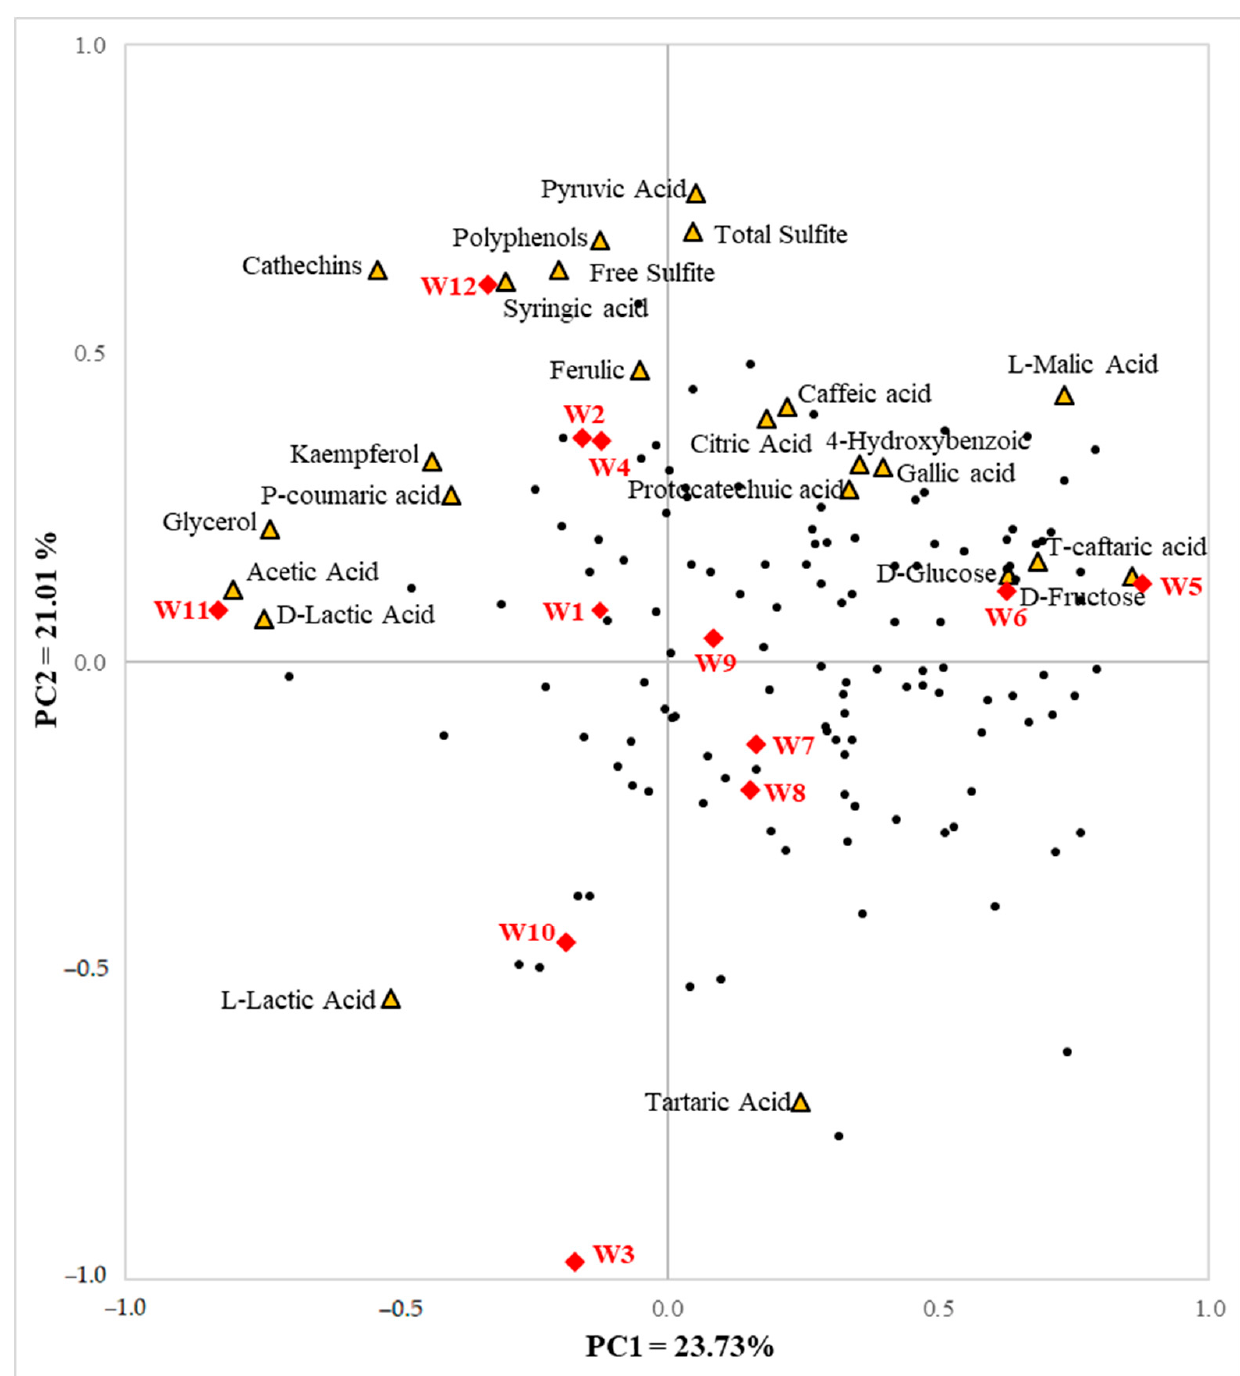
Figure 3. Internal preference map using consumers’ overall preference scores and nonvolatile compounds. The yellow triangles indicate nonvolatile substances, red diamonds indicate white wine samples, and black dots indicate individual consumer preference.